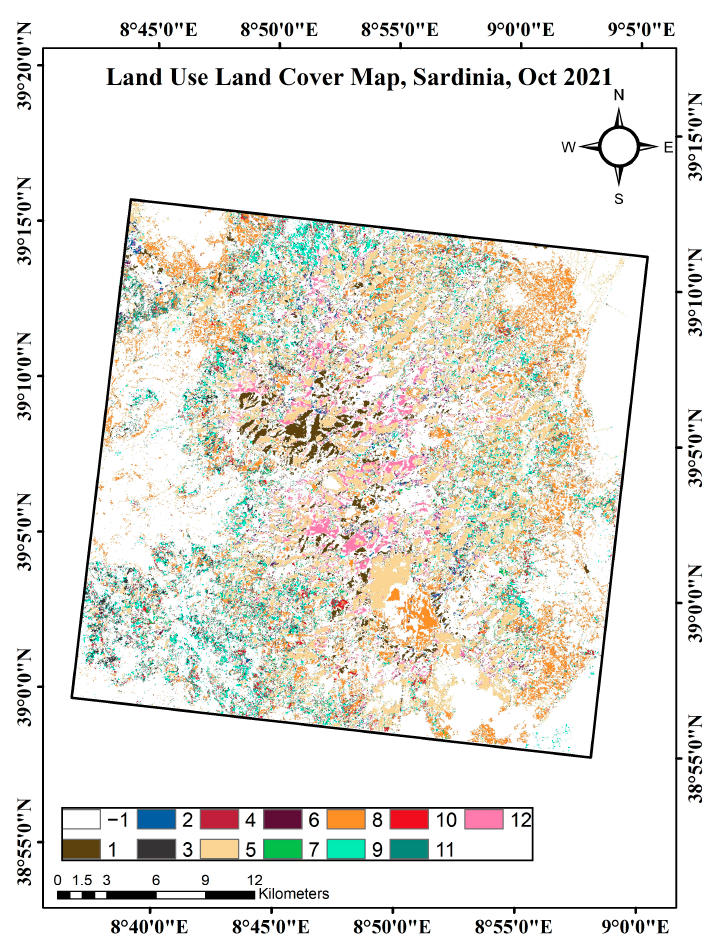
Figure 5. Land use, land cover map of Sardinia—the meaning of each color in the legend is stated in Table 2. Table 2 . Various Classes of Land Use, Land Cover Map .